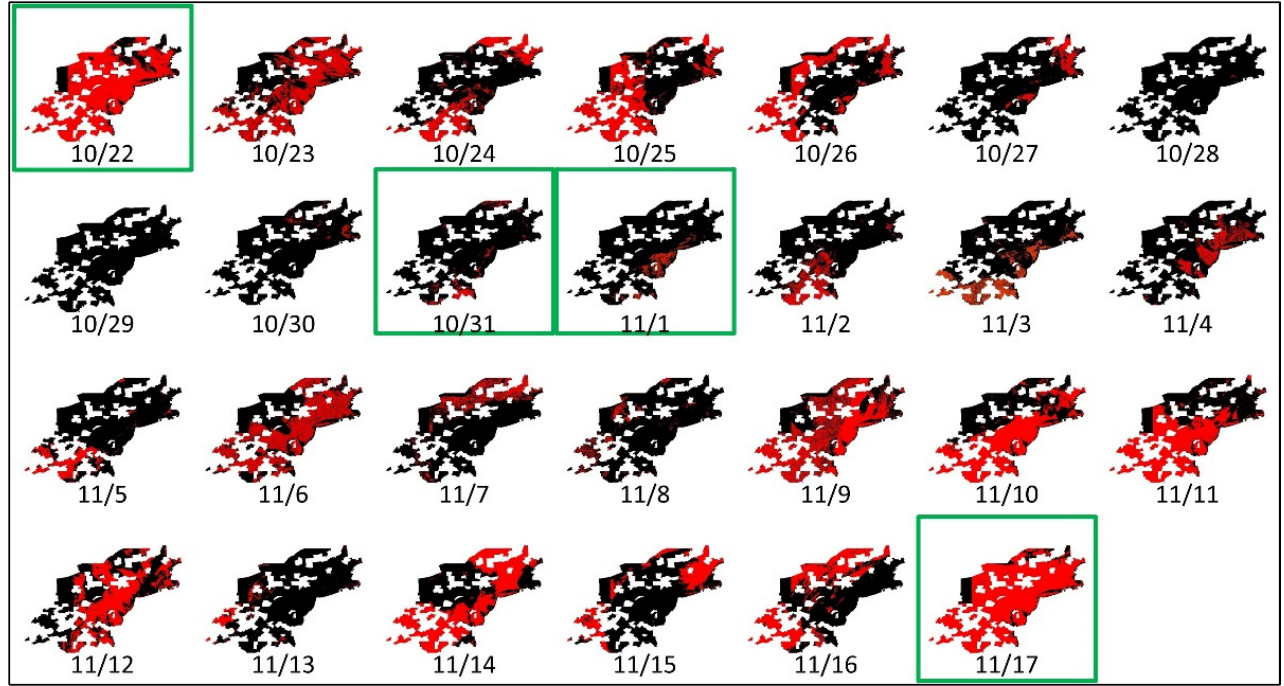
Figure 4. High-quality pixel coverage during Hurricane Sandy (2012) in the northeastern United States, where the red color indicates high-quality pixels, the black background is the study area (i.e., 66 CBSAs in the Northeastern US), and the green boxes indicate dates selected.